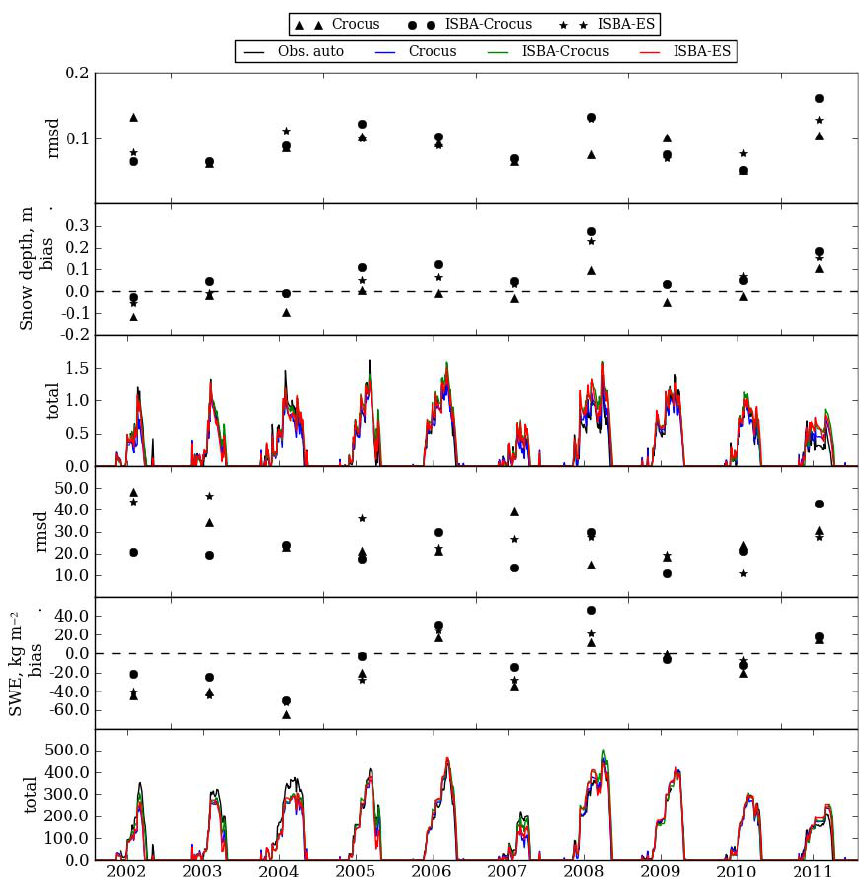
Fig. 6. Overview of ten years of simulation at Col de Porte, France. Simulated data for snow depth (top) and SWE (bottom) are provided for two model runs with two snowpack schemes within SURFEX (ISBA-ES and ISBA-Crocus) and the stand-alone Crocus model, compared to daily in-situ data. Statistics (rmsd and bias) for SWE and snow depth are provided individually for each snow season.